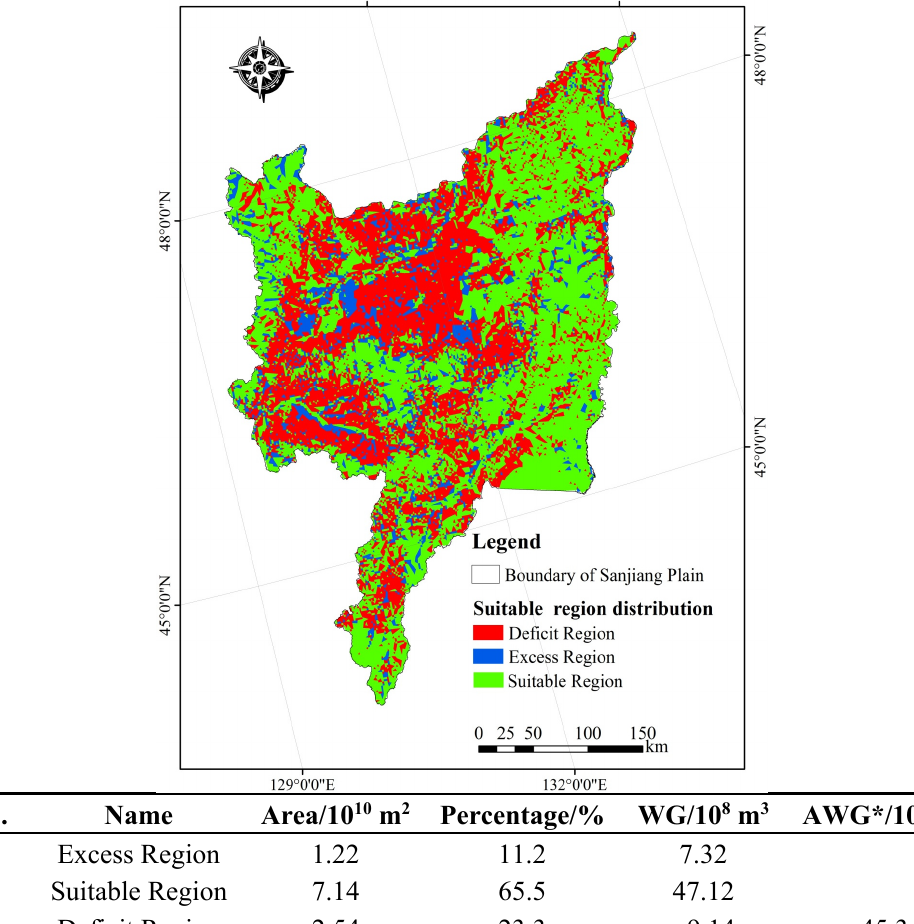
Figure 14. Distribution of areas whose shallow groundwater depth is within ( i.e. , suitable) or outside of ( i.e. , deficit and excess) EISGD and the withdrawal shallow groundwater (WG) for different regions of the Sanjiang Plain, northeast China. * AWG = allowable withdrawal shallow groundwater for total Sanjiang Plain—Stands for water shortage reaching the range of